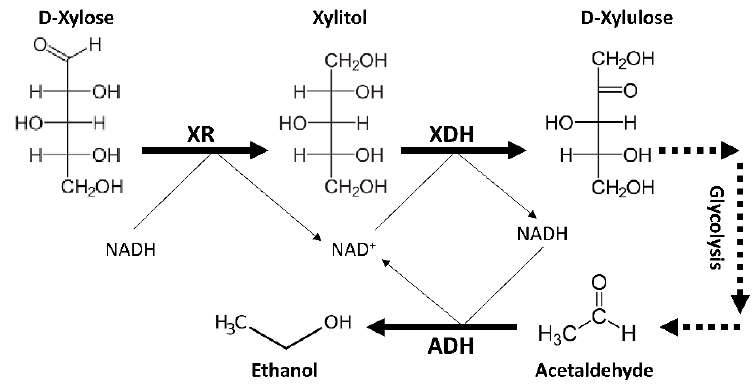
Figure 2. Schematic model of the central metabolism for bioethanol production from xylose indicating the rate limiting steps (XR: xylose reductase; XDH: xylitol dehydrogenase, and ADH: alcohol dehydrogenase) and cofactors demand / balance in most of native xylose metabolizing yeasts. Xylose assimilation reactions starts with XR to produce xylitol. The xylitol is further metabolized by XDH to produce xylulose, which further metabolized to xylulose-phosphate to enter the glycolysis (indicate by black dotted arrow and summarized in Figure 1) to produce acetaldehyde. The acetaldehyde finally converted to ethanol by ADH.